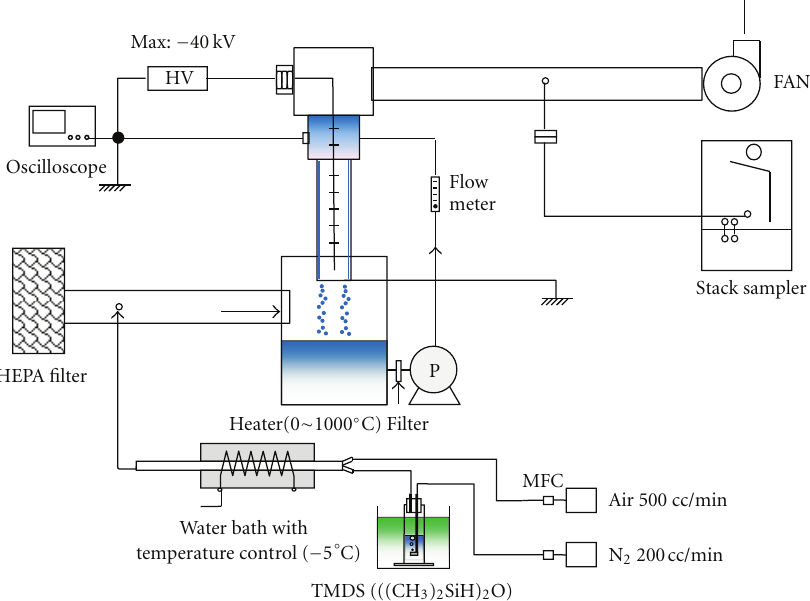
Figure 1: Experimental setup to measure the collection e ffi ciency of the modified wet ESP investigated in this study.